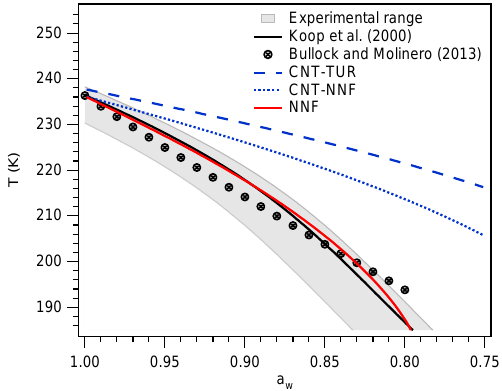
Figure 6. Freezing temperature for homogeneous nucleation. T f Fig. 6. Freezing temperature for homogeneous nucleation. T f was found by application of Eq. (30) assuming D p =10 (cid:22) mand (cid:1) t =10 s. LinesCNT-TURandCNT-NNFandCNT-EMPcorrespondtoclassicalnucleation was found by application of Eq. (30) assuming D p = 10µm and theoryusing (cid:27) iw fromEqs. (25),(27)and(29),respectively. T f obtainedusingtheK00parameterization(Koop 1t = 10s. Lines CNT-TUR and CNT-NNF and CNT-EMP corre- etal.,2000;KoopandZobrist,2009),theNNFmodel,andthecorrelationofBullockandMolinero(2013)are spond to classical nucleation theory using σ iw from Eqs. (25), (27) also shown. The experimental range represents (cid:1) a w =0 : 313 (cid:6) 0 : 025 (Koop and Zobrist, 2009; Alpert et al., and (29), respectively. T f obtained using the K00 parameterization 2011). (Koop et al., 2000; Koop and Zobrist, 2009), the NNF model, and the correlation of Bullock and Molinero (2013) are also shown. The experimental range represents 1a w = 0.313 ± 0.025 (Koop and Zo- brist, 2009; Alpert et al.,